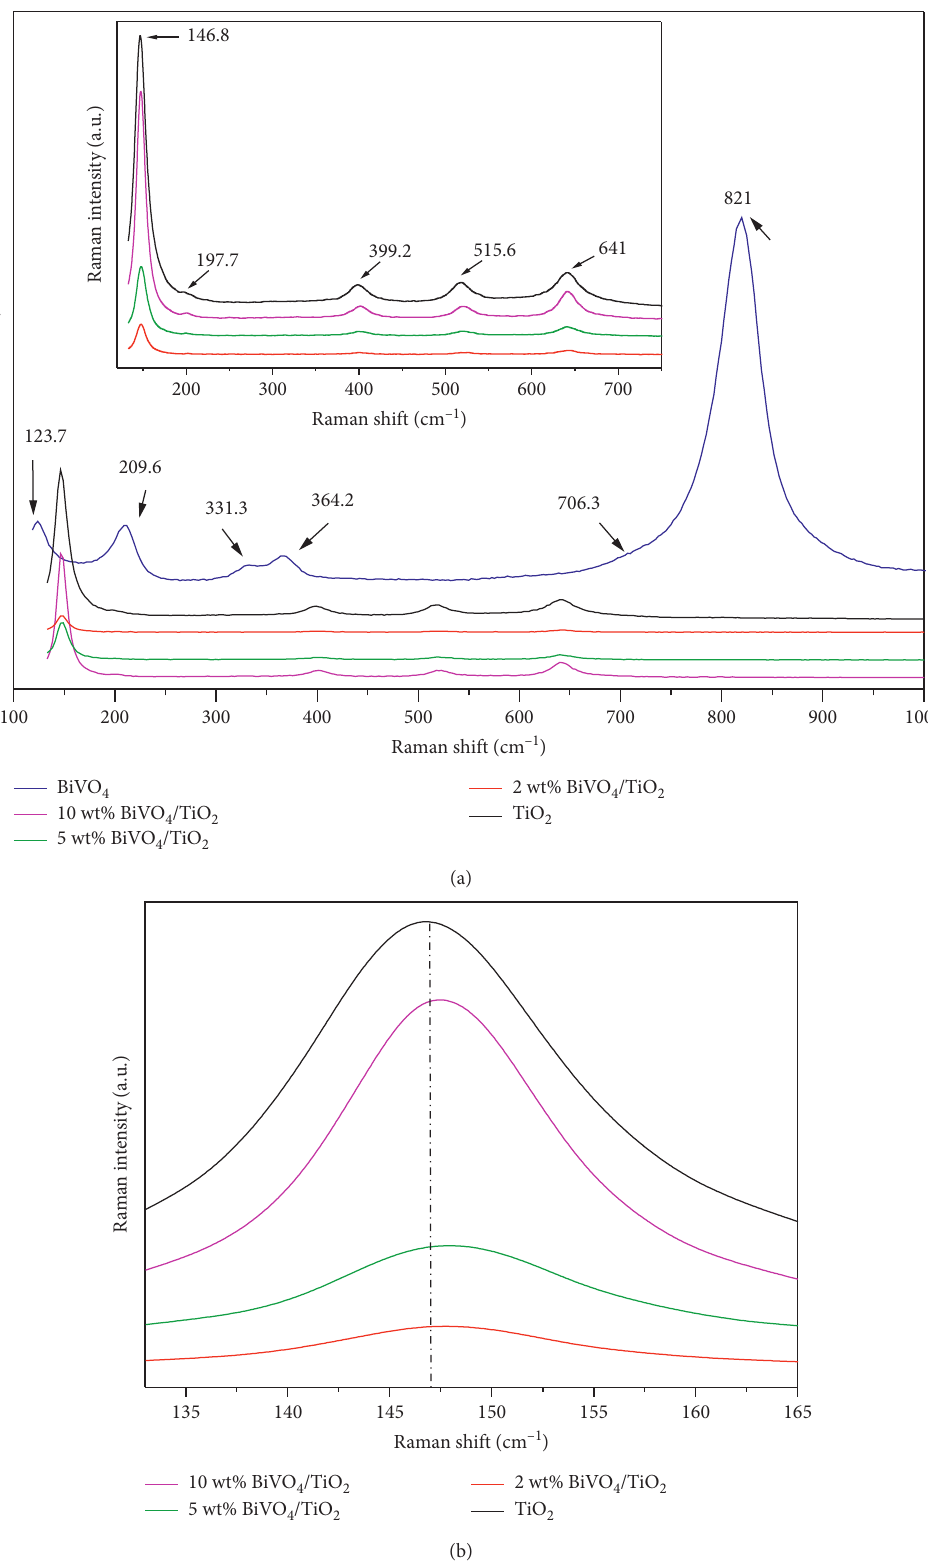
Figure 3: (a) Raman spectra of materials and (b) magnified spectra of the 133–165cm − 1